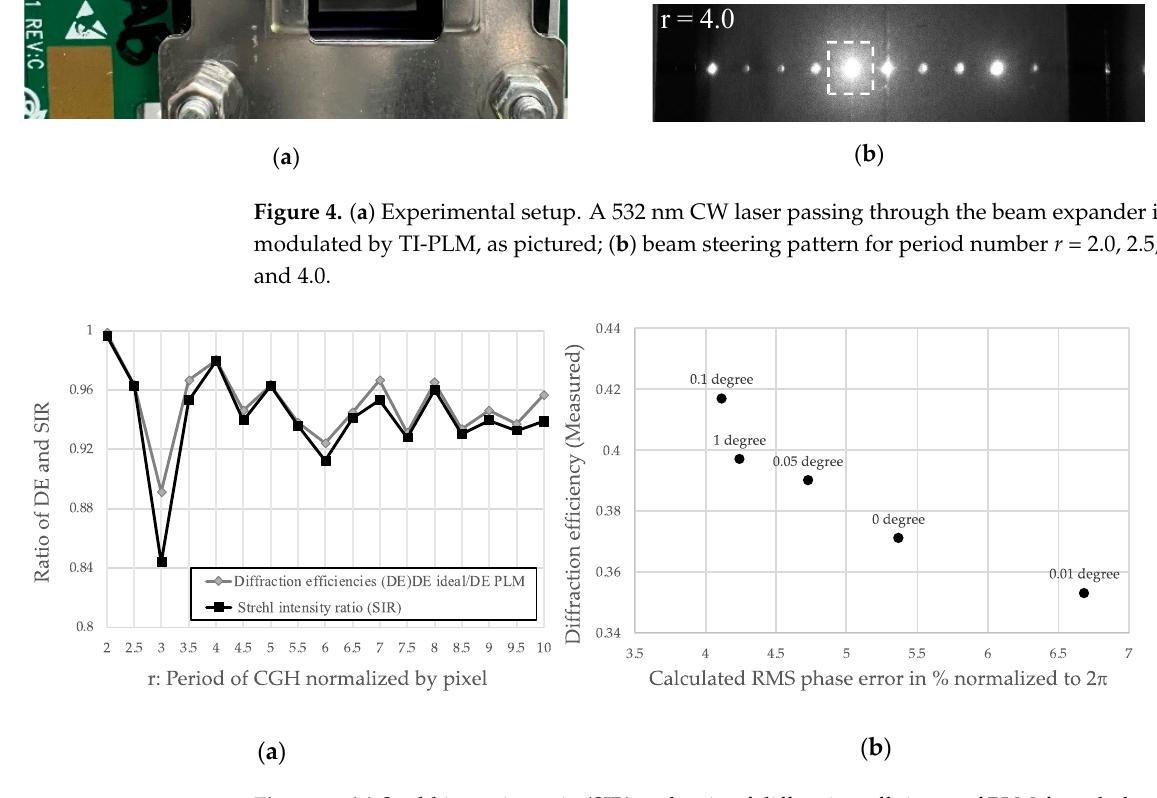
Figure 5. ( a ) Strehl intensity ratio (SIR) and ratio of diffraction efficiency of PLM-forced phase profile correlated with the standard deviation of the phase values via SIR. to sawtooth phase profile, ( b ) measured DE as a function of 𝜎 (cid:3045)(cid:3040)(cid:3046) for the same period ( r = 3) of CGH. to sawtooth phase profile, ( b ) measured DE as a function of σ rms for the same period ( r = 3) of CGH. 𝜎 (cid:3045)(cid:3040)(cid:3046) is controlled by a slight in-plane rotation of CGH. σ rms is controlled by a slight in-plane rotation of